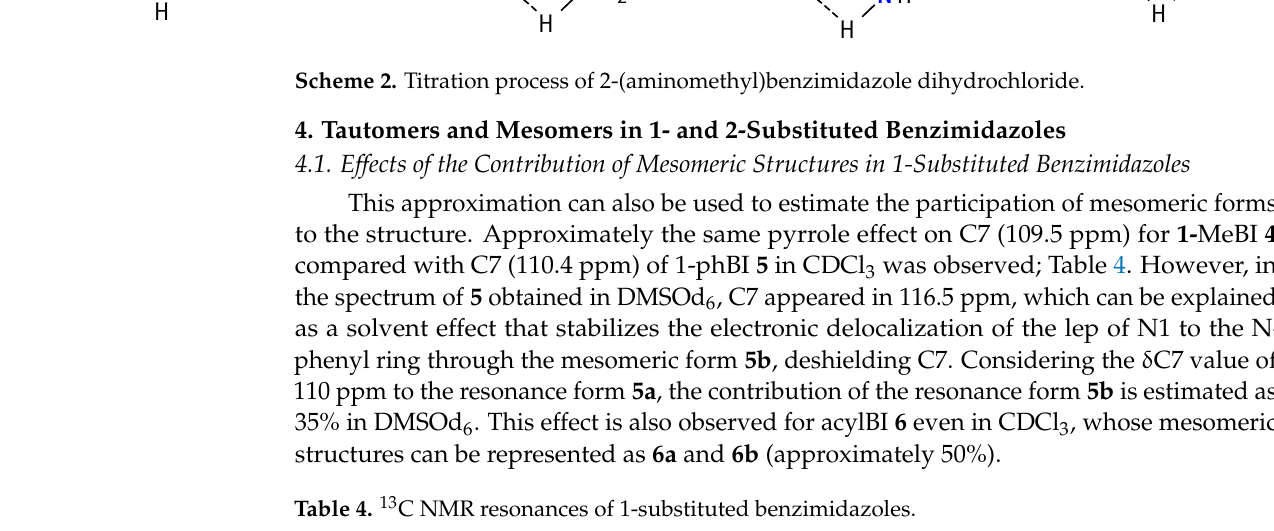
Table 4. 13 C NMR resonances of 1-substituted benzimidazoles.